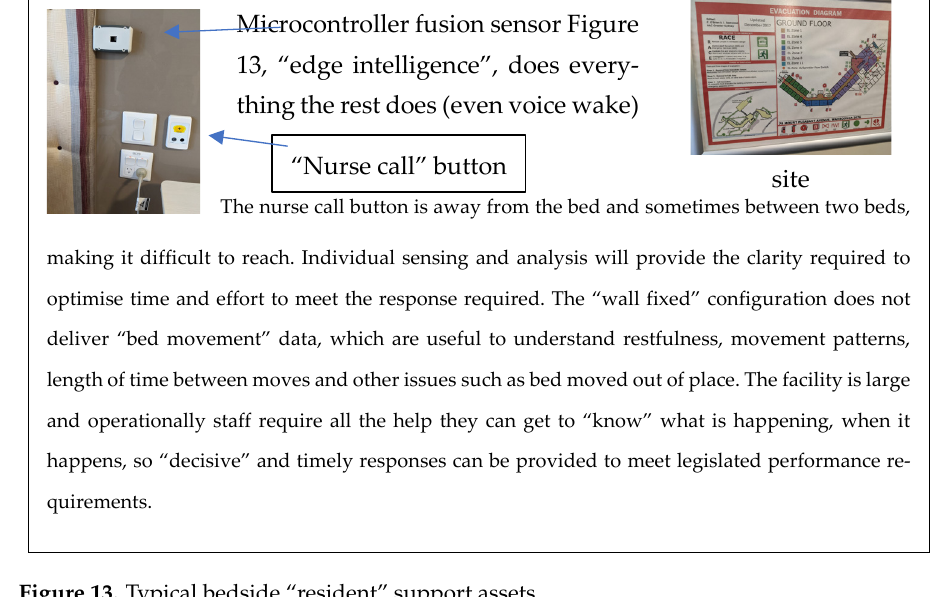
Figure 13. Typical bedside “resident” support assets. Site layout for BLE mesh communications.